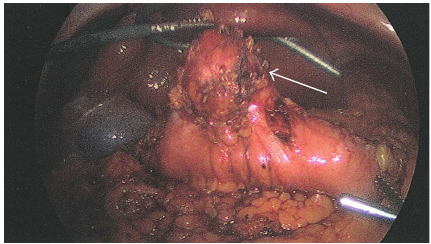
Figure 5: Macroscopic inspection during laparoscopic surgery shows a large exophytic mass along the greater curve in the antrum of the stomach.